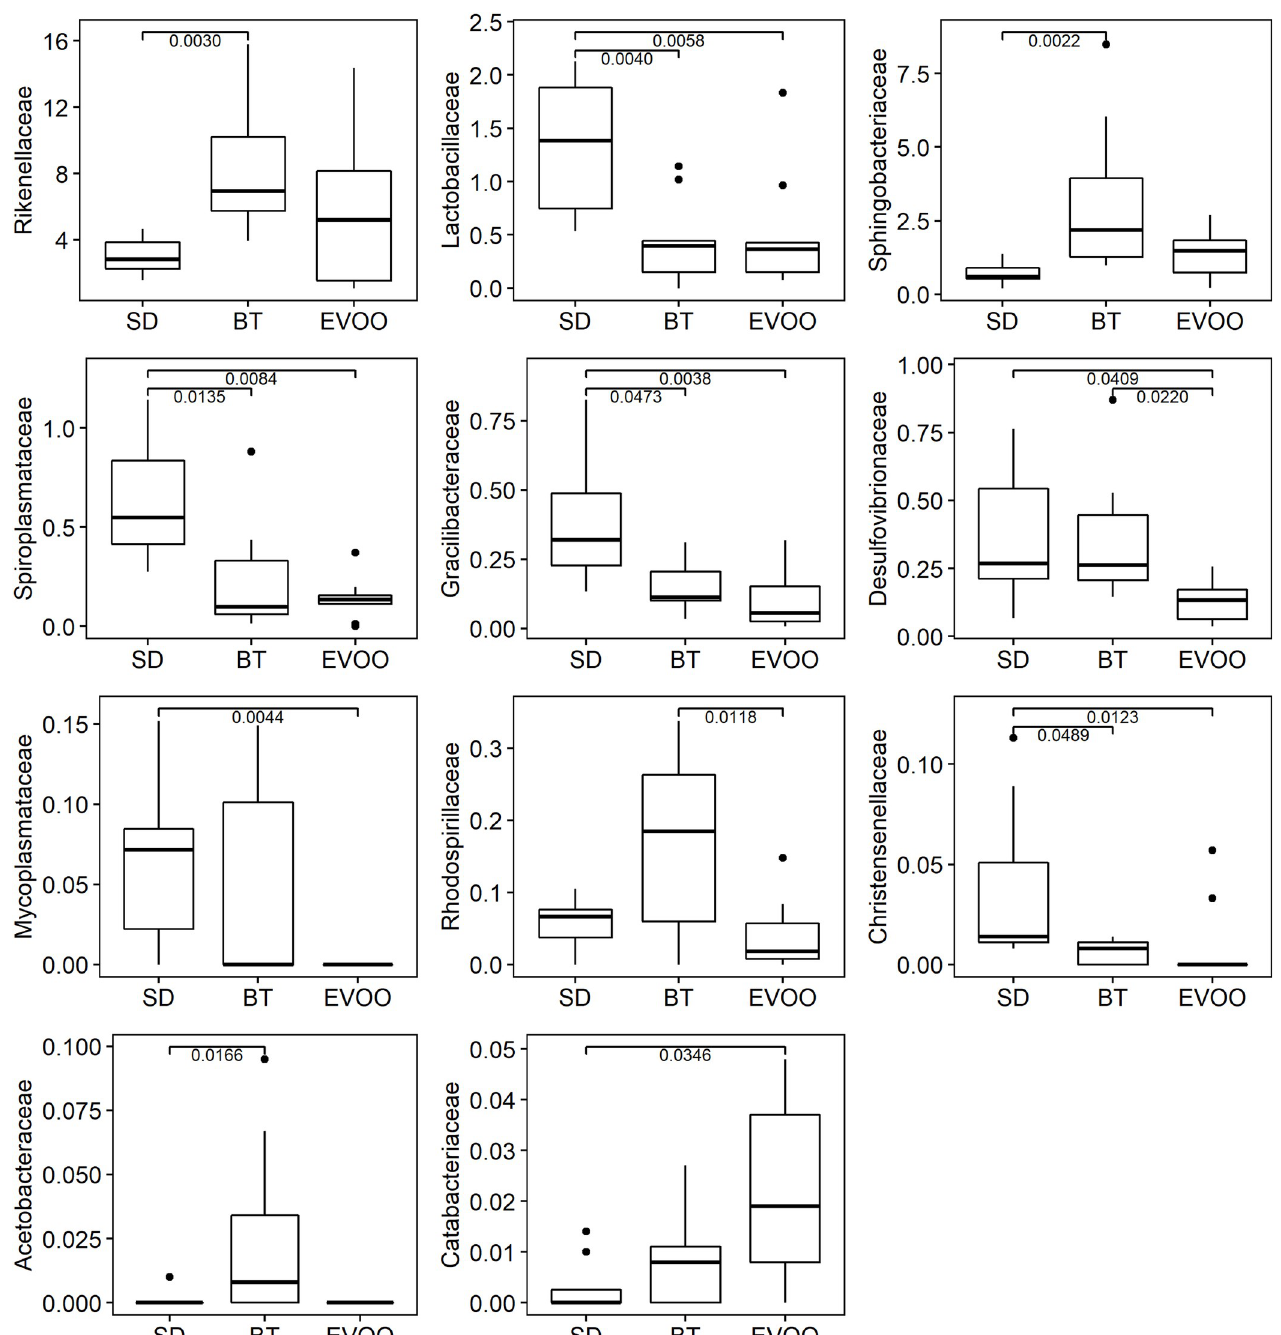
Fig 3. Box-plot representation of the percentage distribution of the eleven families with significant differences (p < 0.05) among mice fed a diet enriched with butter (BT), virgin olive oil (EVOO) or standard chow (SD).